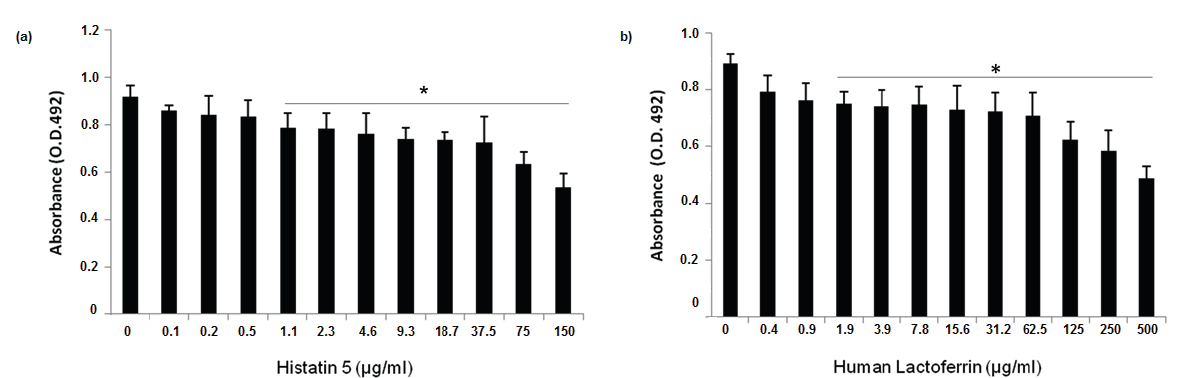
Figure 1 - Effect of histatin 5 ( a ) and human lactoferrin ( b ) on the metabolic activity of biofilm formed by a fluconazole-resistant C. albicans clinical isolate. After adhesion, yeast cells were washed twice with PBS 10 mM pH 7.2 and incubated with histatin 5 for 48 h at 37 ºC. Cell viability was measured by the reduction of XTT salt. *p <